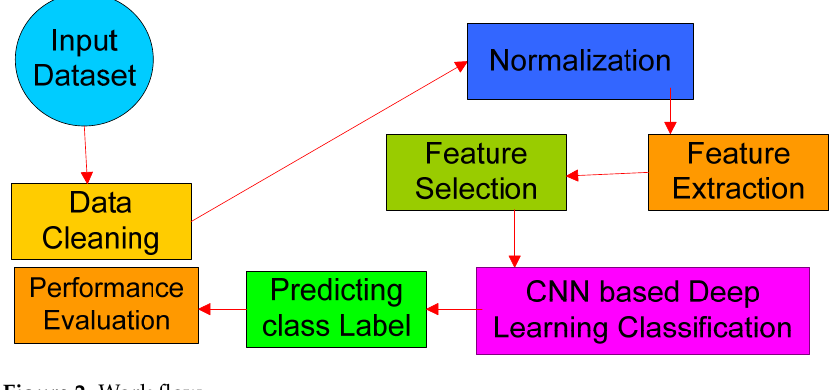
Figure 2. Work flow.